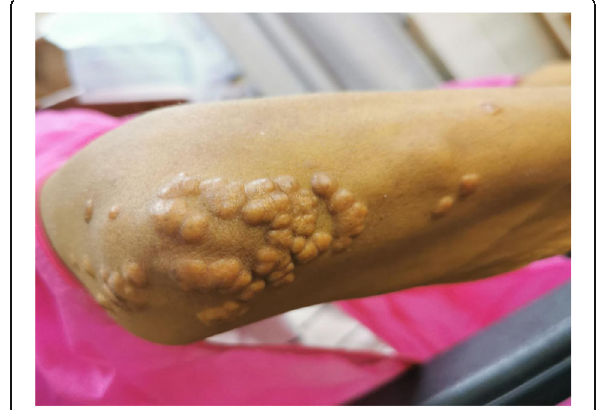
Fig. 1 Numerous xanthomas in the patient. Histopathological assessment of a subcutaneous nodule from the elbow joint revealed that it was